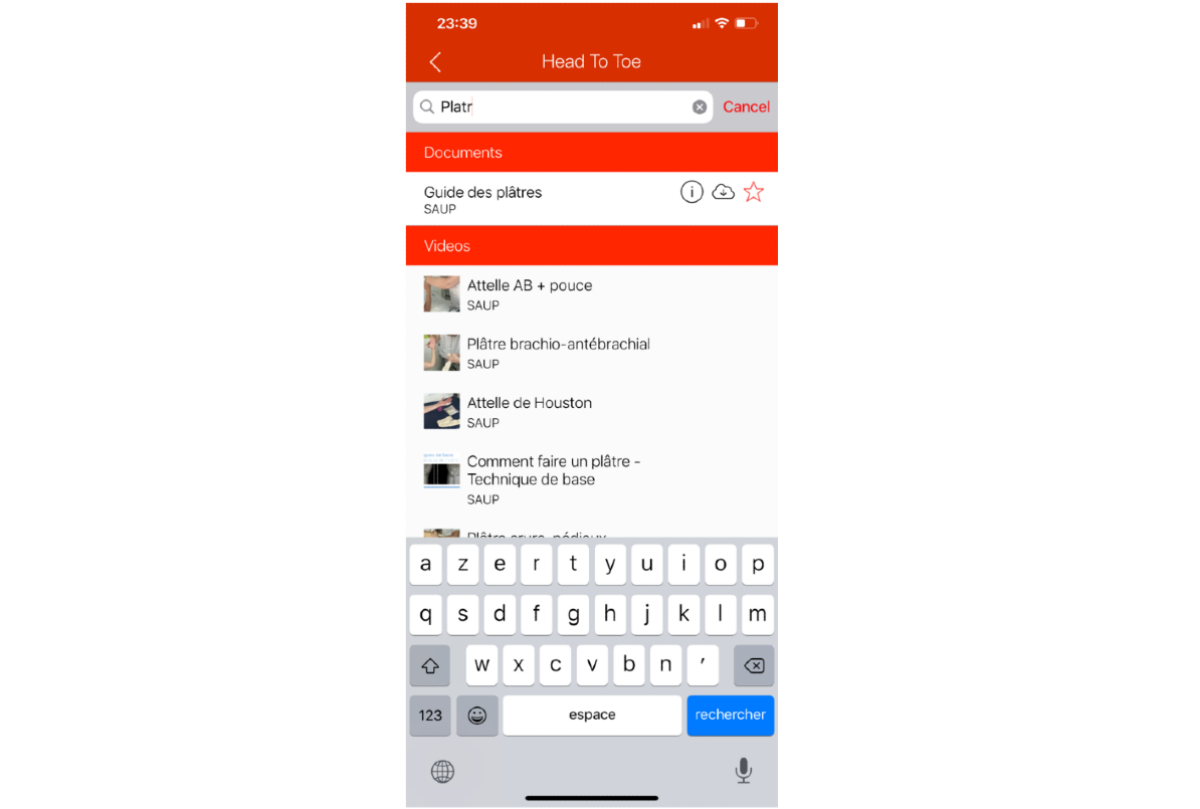
Figure 7. The search screen of the HeadToToe platform (in French). Users can search through all types of content from this screen and quickly access needed